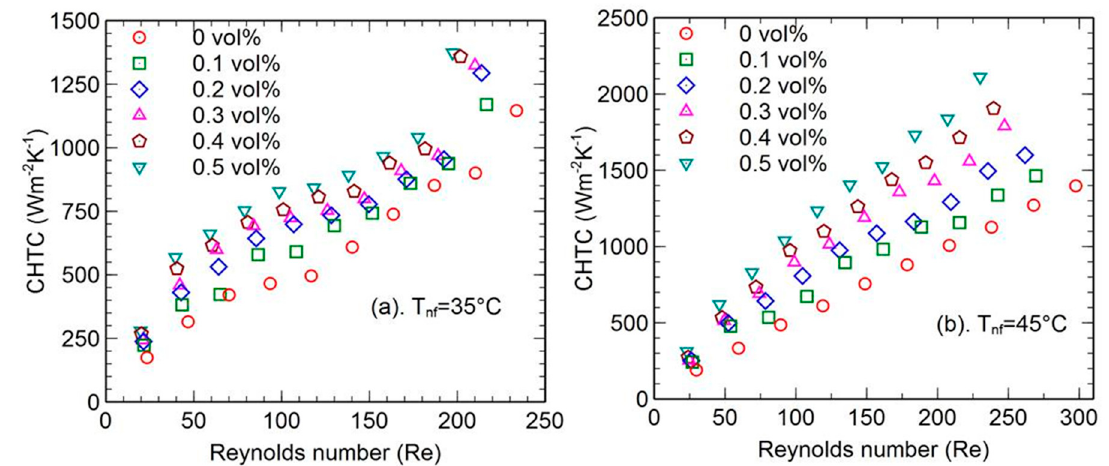
Figure 7. Variation of CHTC in automobile radiator [107].